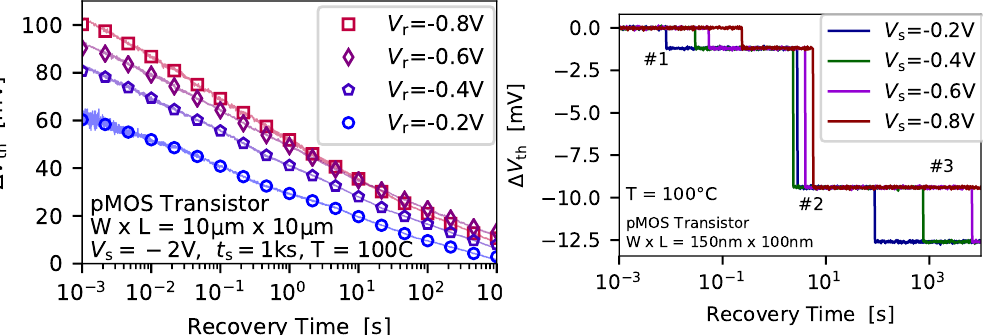
Figure 6. The recovery of the threshold voltage for pMOS transistors is shown from the perspective of a ( left ) large-area transistors and ( right ) a nanoscale transistor. In case of large-area devices the ∆ V th shift which recovers appears to be seemingly lower at lower recover bias. However, the main reason for this observation is that the trap level of most of the defects is shifted far above the Fermi level of the channel, compared to the case for larger recovery biases, which leads to small charge emission times below the measurement delay. Thus, a significant bias dependence of the overall device recovery can be observed. The recovery behavior of defects from a nanoscale device exhibit emission times which can be either change with recovery bias (defects #1 and #3), or can be independent of the selected recovery bias (defect #2). Also remarkable is that defects can become shifted outside measurement window when the recover bias becomes too